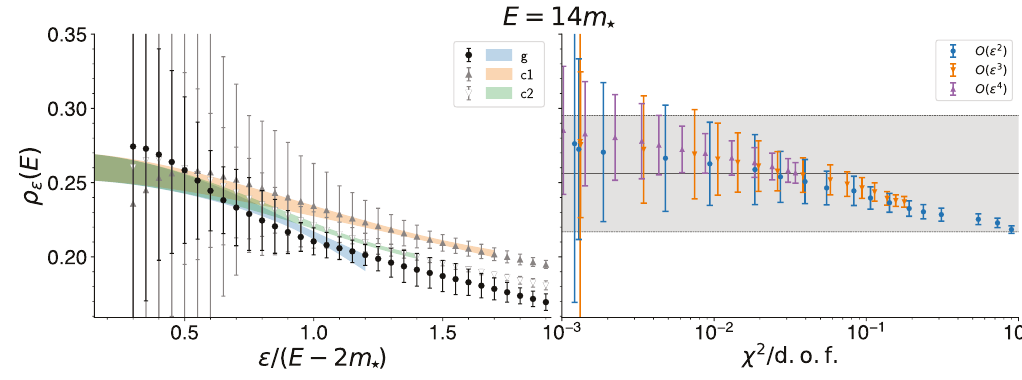
Figure 8 . Left : a sample constrained extrapolation of the g , c1 , and c2 kernels at E = 14 m ? with the (constrained) extrapolation form including terms up to O ( (cid:15) 4 ) . Right : summary of the extrapolated values for different extrapolations forms and different extrapolation ranges [ (cid:15) min , (cid:15) max ] with (cid:15) min = 0 . 3( E − 2 m ? ) fixed and varying (cid:15) max . For each (cid:15) max , the extrapolated result is plotted with the correlated χ 2 / d . o . f . as the horizontal coordinate. The horizontal band shows the final estimate for the extrapolated values, with statistical and systematic errors combined in